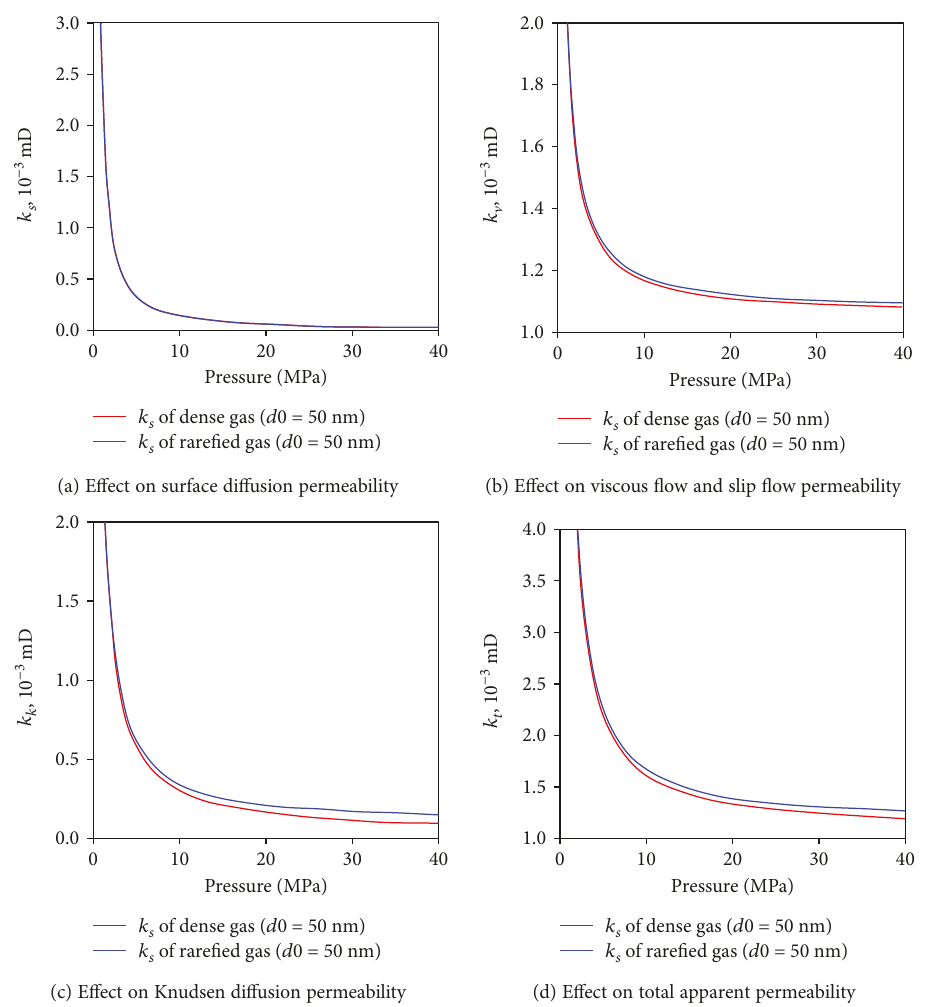
Figure 17: The e ff ect of gas density on apparent permeability of shale (pore diameter = 50nm